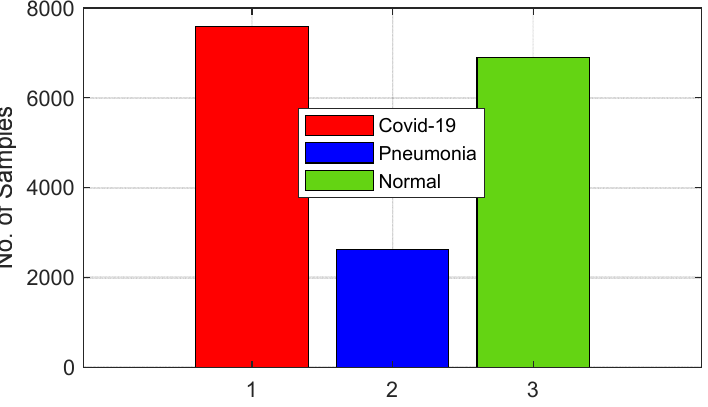
Figure 1. Distribution of Classes in the Image Database. Figure 2 provides some sample lung CT scan images of COVID-19 infected patients. Figures 3 and 4 show some lung CT scan image samples of viral pneumonia patients and some normal lung CT scan image samples, respectively.